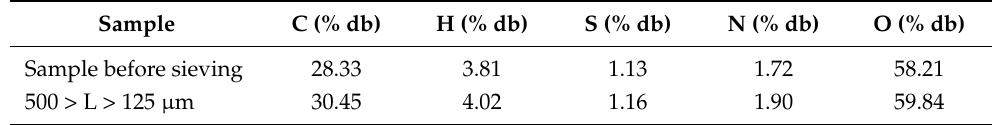
Table 5. Ultimate analysis of PO